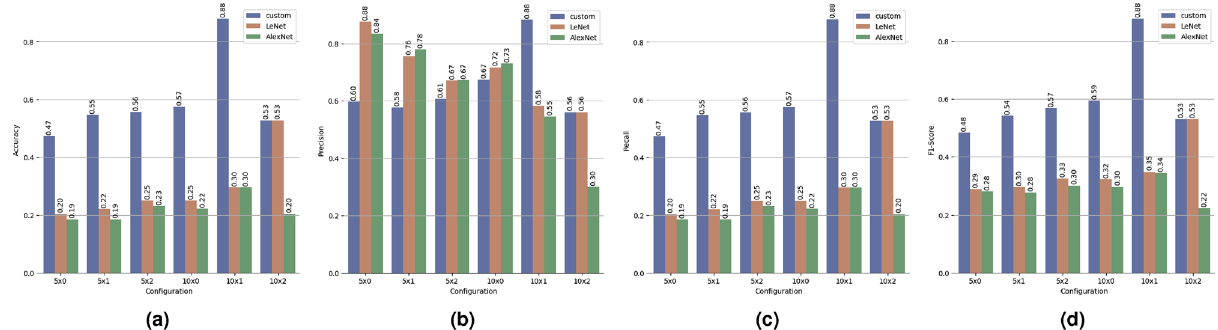
Figure 5. Key Performance Indicators (KPI)’s: Accuracy, Precision, Recall and F1-score, for each of the trained models and each configuration proposed ( C 5 × 0 , C 5 × 1 , C 5 × 2 , C 10 × 0 , C 10 × 1 , and C 10 × 2 ).